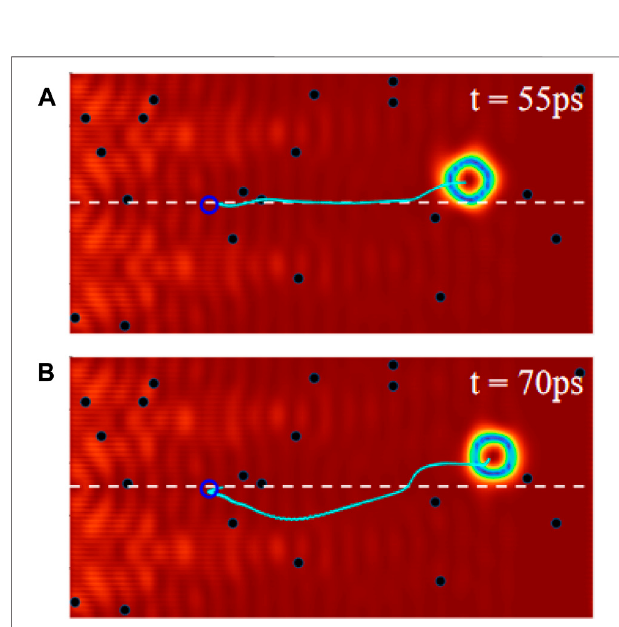
FIGURE5| TheAFMskyrmionmotioninthepresenceofthedefectfor (A) A / J (cid:1) 0.05and (B) A / J (cid:1) 0.15.Theblackdotsarethedefects,andthewhitedashedlines represent the intersection of the two spin wave sources.